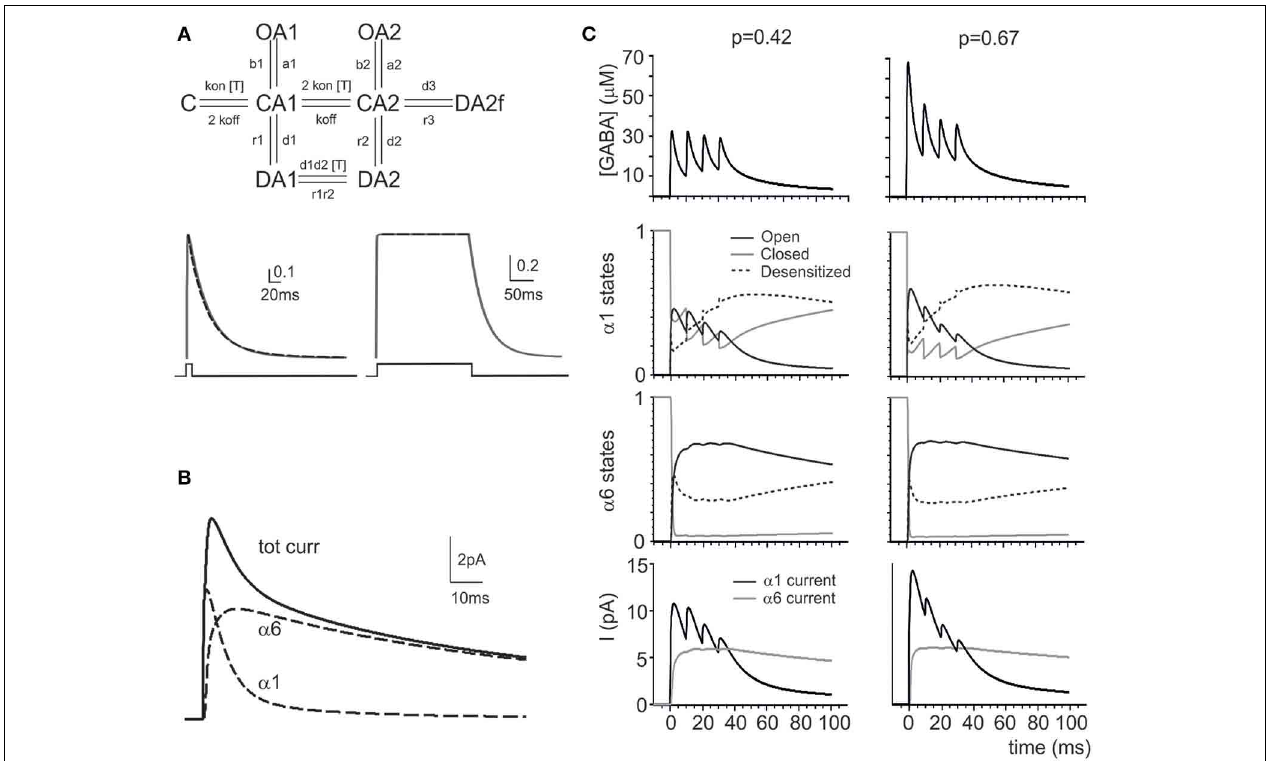
FIGURE 2 | Modeling GABA receptor-mediated responses in the cerebellar glomerulus. (A) Schematic representation of the kinetic scheme for α 1 and α 6 subunit-containing receptors (modified from Pugh and Raman, 2005). The traces ( continuous lines ) show responses to brief and long 1mM GABA pulses (taken from Tia et al., 1996). The simultaneous fitting of the decay phase of the α 6 response to a fast (1ms) GABA neurotransmitter pulse (1mM) and of the almost constant response to a long (200ms) GABA neurotransmitter pulse (1mM) is shown ( dashed lines ) (see Methods and Table 3 for details). (B) The simulated eIPSC generated by the model at 0mV in response to a 1ms GABA pulse shows amplitude and kinetics reproducing experimental eIPSCs. The contribution of the α 1